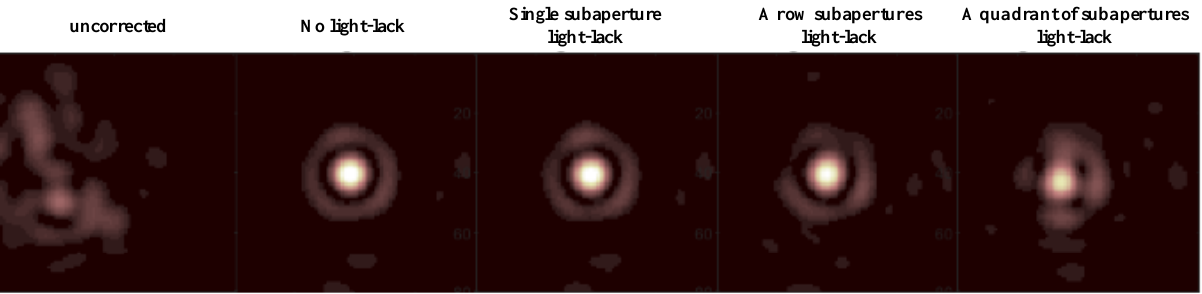
Figure 6. Effected images of a point target in an I-wave band with different light-lack situations. At the same time, the evolution of the reconstructed wavefront in 200 frames at different values of r 0 was simulated, as shown in Figure 7. The fluctuation of the RMS at different frames was caused by the randomness of the turbulence, with the increasing of r 0 , the smaller the fluctuation was. On the whole, the RMS of the residual wavefront after correcting was increased with the numbers of the under-sampling sub-apertures but decreased with the increase of r 0 . However, the reconstructed wavefront under-sampled with a single sub-aperture lack of light was nearly the same as that of the completed corrected. For the weak turbulence (r 0 is 15 cm), the difference for the three cases with light-lack is smaller, which means the influence of under-sampling is